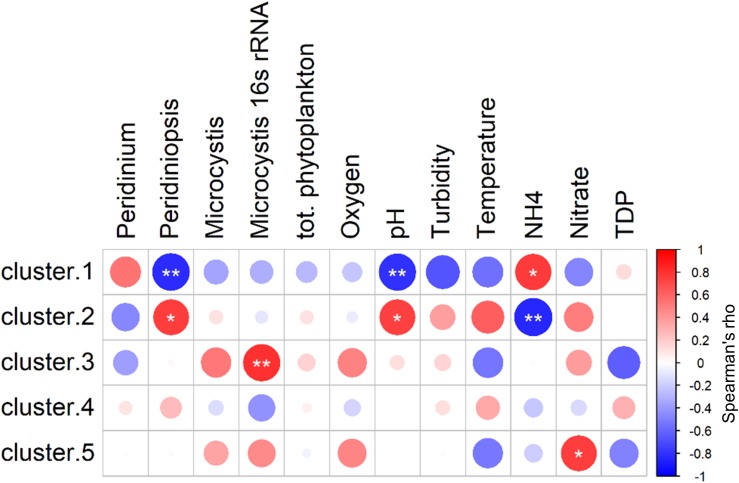
Spearman cross-correlations between centroids of each of the five clusters and environmental parameters. Cluster 1: descending abundance, Cluster 2: ascending abundance, Cluster 3: high abundance throughout the study period, Cluster 4: intermediate abundance throughout the study period, Cluster 5: OTUs found at intermediate abundance in the middle of the study period. Peridinium population (mm2/mm3), Peridiniopsis, Peridiniopsis population (mm2/mm3), Microcystis, Microcystis population (mm2/mm3), TDP, total dissolved phosphorus, (mg L–1). Starred Circles represent significant correlation (one star: 0.01 < p < 0.05, two stars: p < 0.01). Analysis was performed using ‘psych’ package in R (Revelle, 2013).